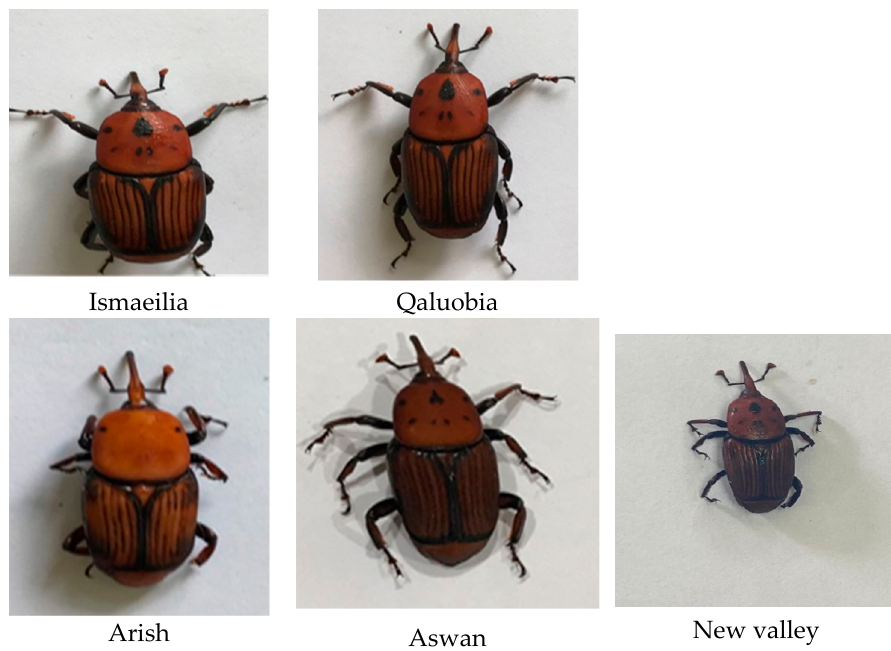
Figure 2. Adults of R. ferrugineus brought from various five geographic locations, showing the same general colour and high variability of black spots (X5).